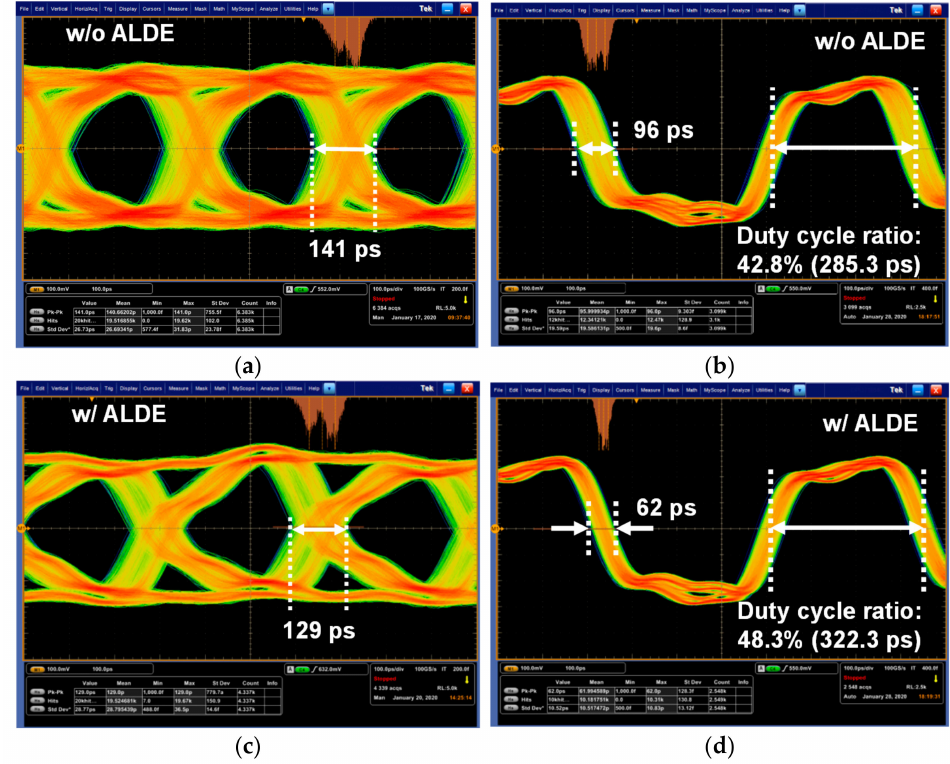
Figure 17. Measured eye diagrams of received data and recovered clock: ( a ) Received data without ALDE; ( b ) Recovered clock without ALDE; ( c ) Received data with ALDE; ( d ) Recovered clock without